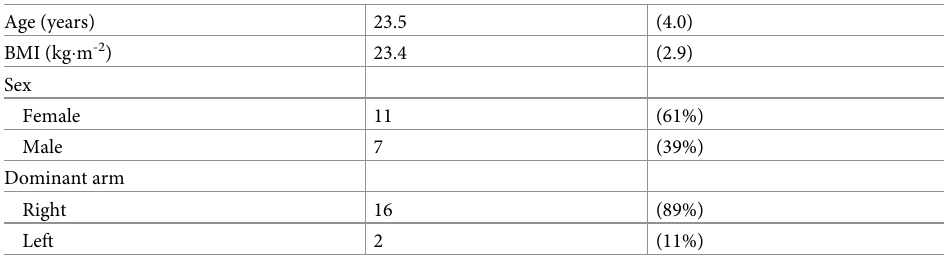
Table 1. Demographics of the study